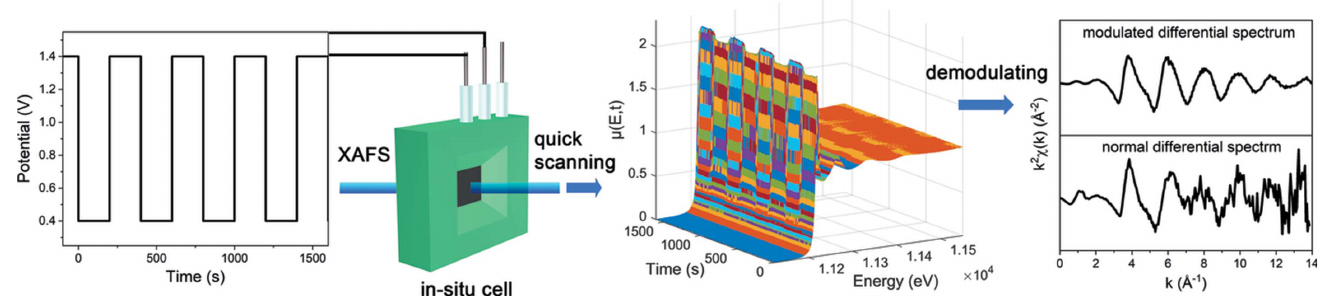
Figure 3 Schematic representation of the testing method of electrochemical modulating differential